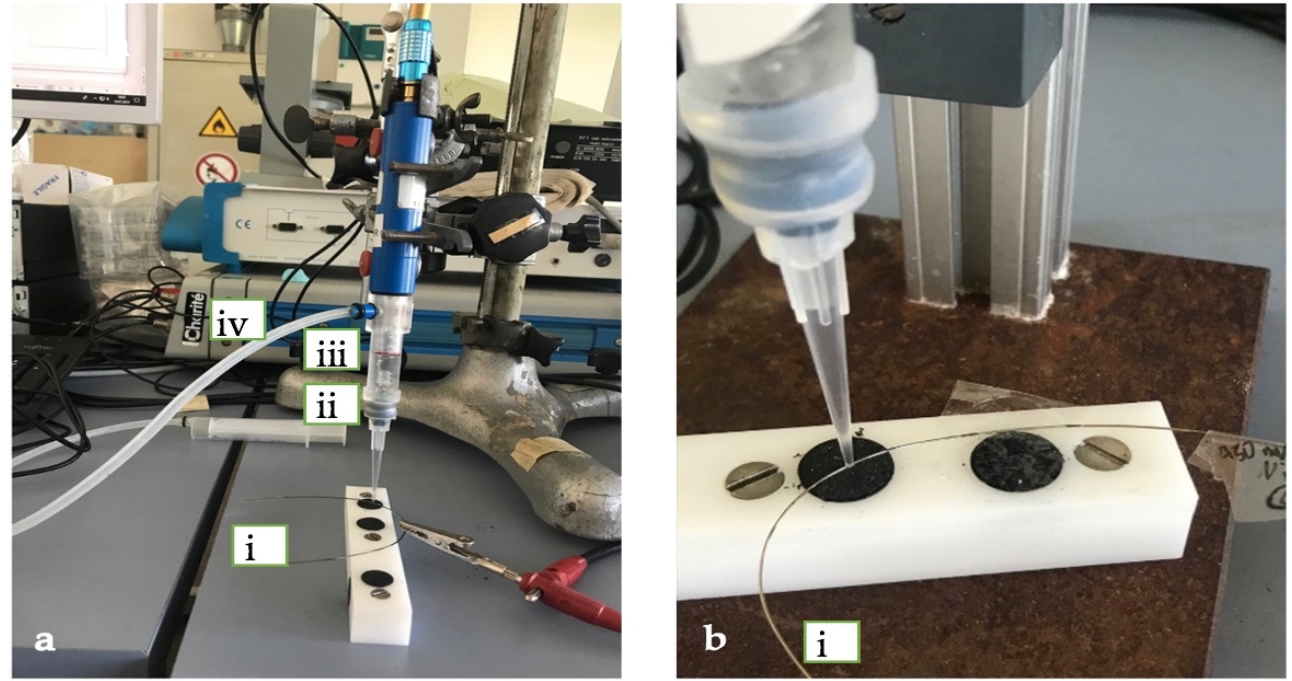
Figure 3. The setup for the electrochemical measurements ( a ) ( i ) Working electrode (orthodontic wire); ( ii ) Platinum wire (CE); ( iii ) Saturated calomel electrode (RE); ( iv ) Potentiostat and ( b ) a close-up picture of the contact point of the tip of the MCS with the working electrode ( i ) Working electrode (orthodontic wire).